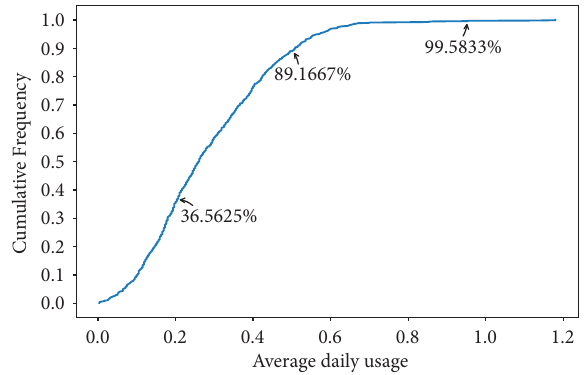
Figure 9: Cumulative curve of usage